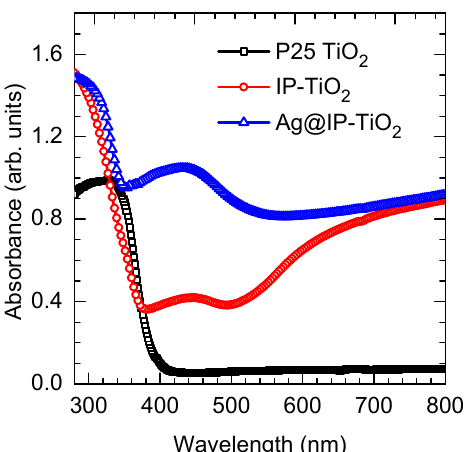
Figure 3. UV-VIS absorption spectra of P25 TiO 2 , IP-TiO 2 , and Ag@IP-TiO 2 .